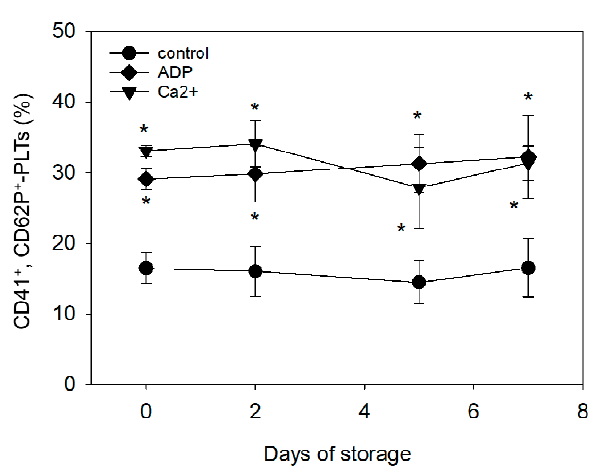
Figure 3. Flow-Cytometric (FCM) analysis of CD41- and CD62P-double-positive platelets in platelet fractions that were prepared from fresh or stored WB samples and stimulated with 10 mM ADP or 0.1% CaCl 2 for 15 min ( n = 4). * p < 0.05 as compared with control platelets at the same time points. No significant differences were observed in time-course changes. In the liquid fraction of WB samples, Ca 2+ levels remained similar throughout the storage period, whereas glucose levels, mostly increased by ACD-A, decreased with storage time (Figure 4a and b). Plasma pH stayed at 7.5 ~ 8.0 (Figure 4c).